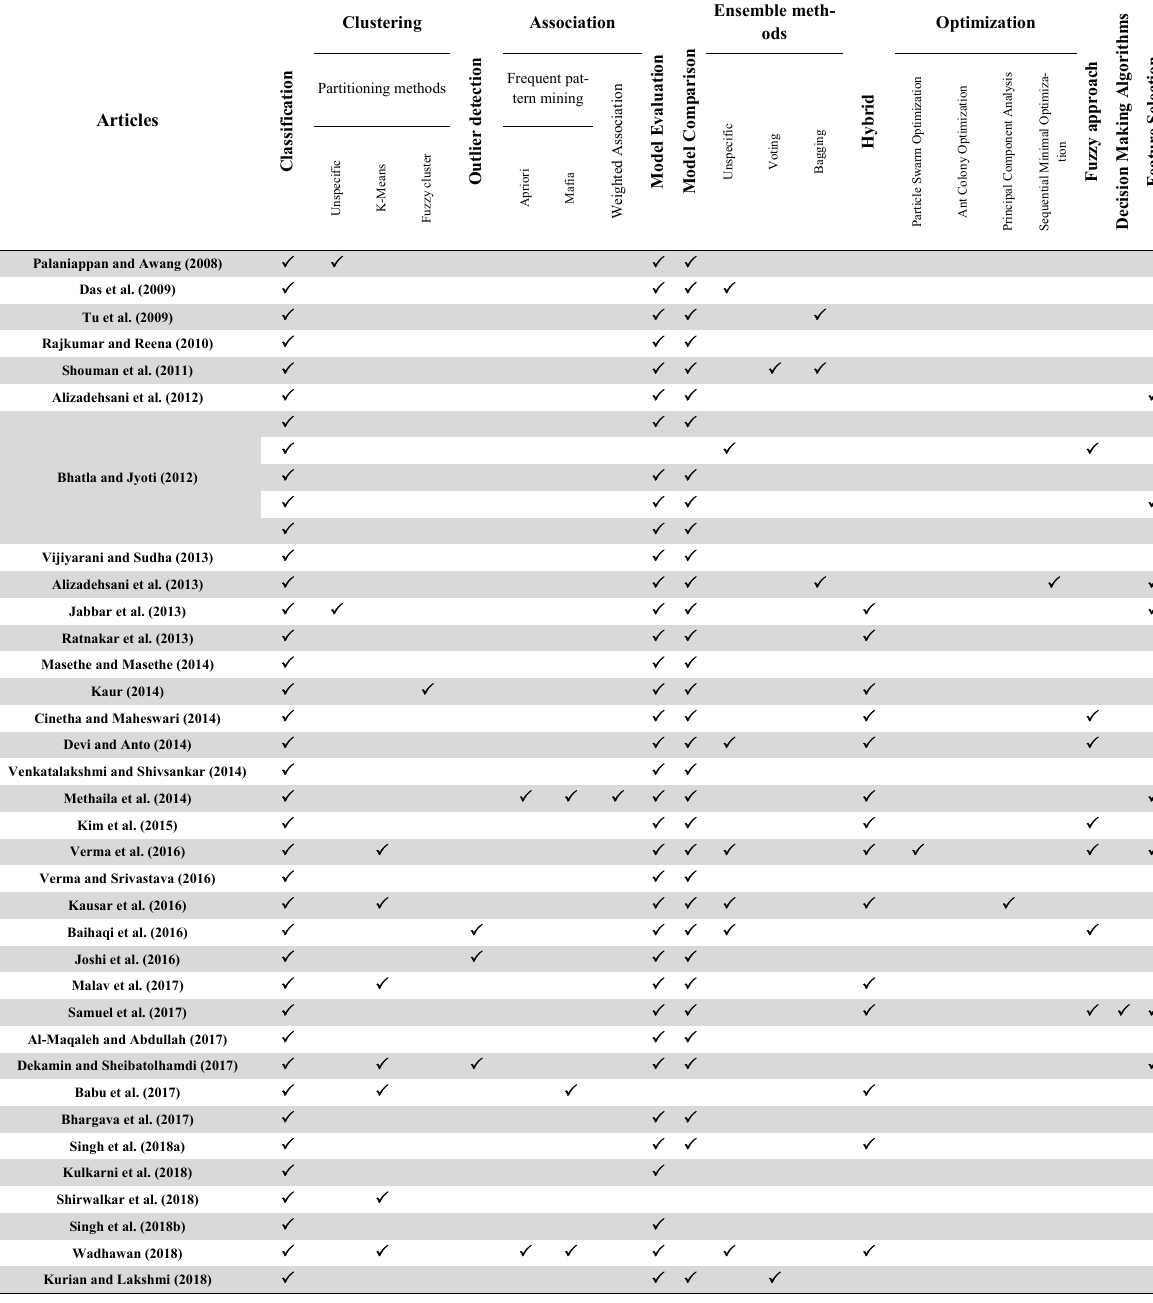
Table 1 exposes comprehensive information about the all implemented methods, and the concept of each paper is discussed as